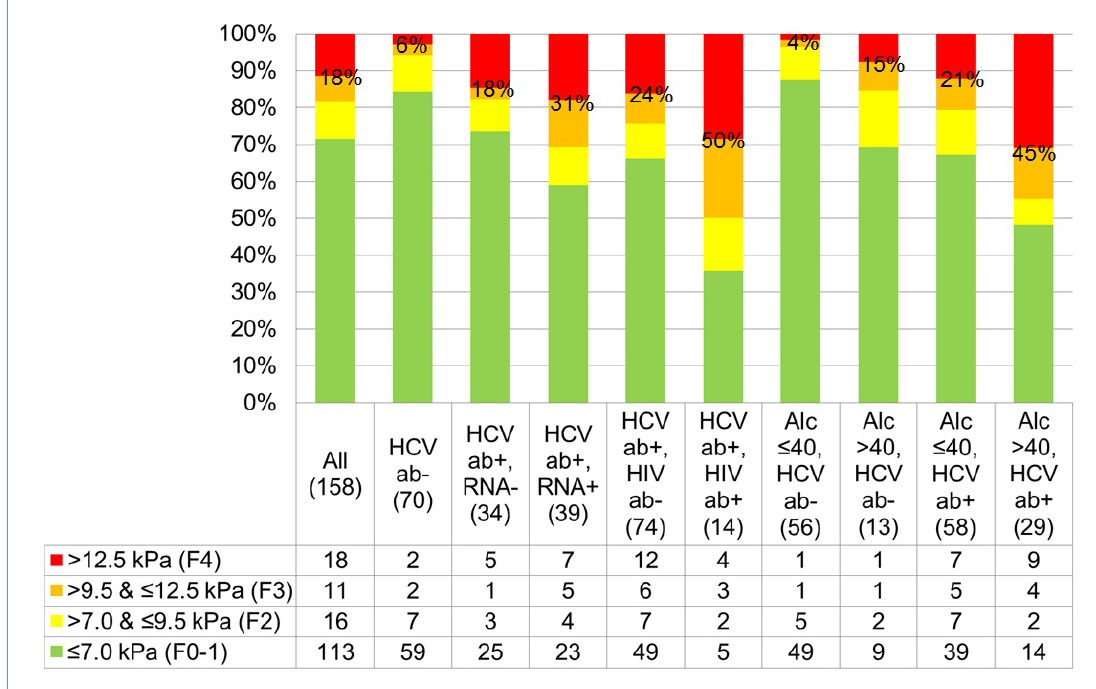
Figure 6: Fibroscan ® results and proportion with severe fibrosis/cirrhosis (Metavir F3/4; liver stiffness >9.5 kPa) in different risk groups.HCV ab– = hepatitis C virus antibody negative; HCV ab+ = hepatitis C virus antibody positive; HIV ab– = human immunodeficiency virus antibody negative; HIV ab+ = human immunodeficiency virus antibody positive; Alc ≤40 = alcohol intake ≤40 g/d; Alc >40 = alcohol intake >40